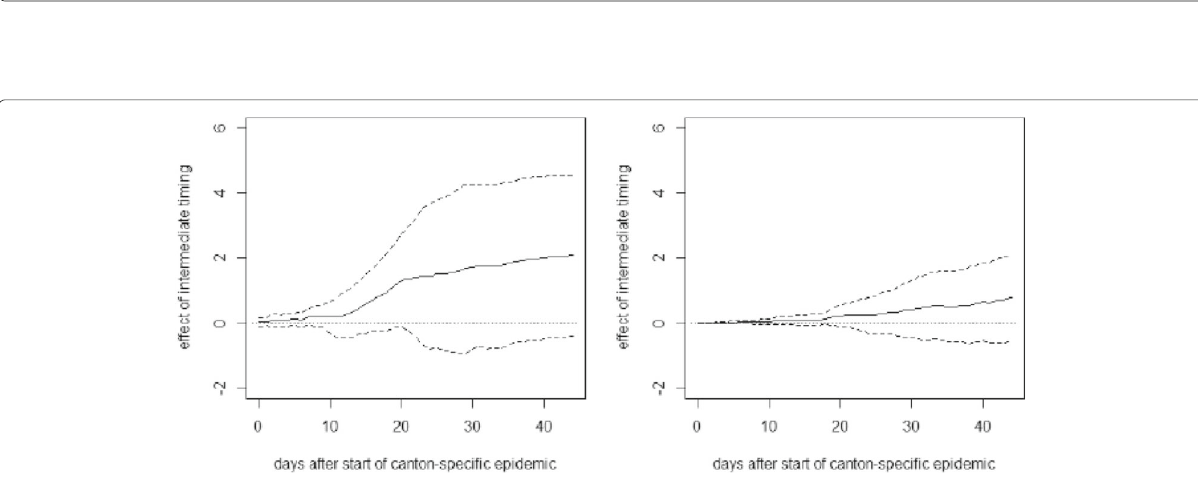
Fig. 15 OLS effect of late timing of measures on cumulative hospitalizations (left) and deaths (right) per 10,000 inhabitants with covariates including Ticino